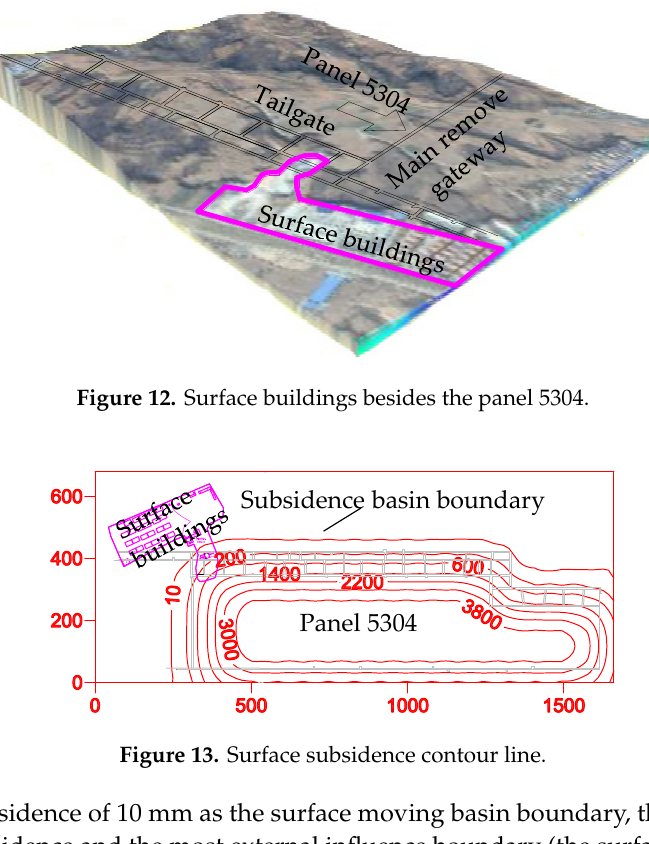
Figure 12. Surface buildings besides the panel 5304.